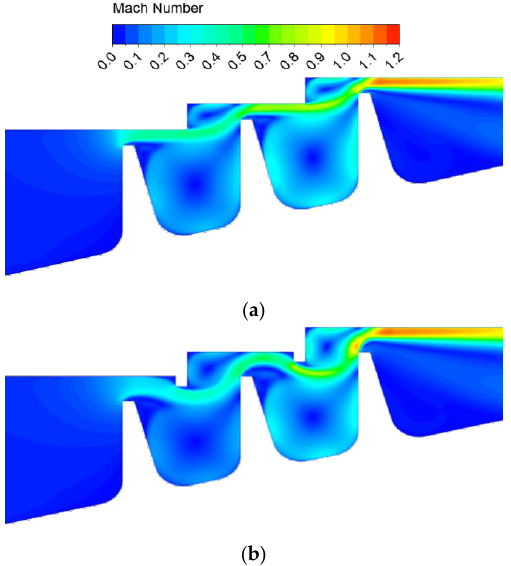
Figure 7. Mach number contour plots for the conventional and ribbed seal (PR = 2.5, S/H = 0.6, t/K = 0.1, β = 90°). ( a ) Conventional seal. ( b ) Ribbed seal.